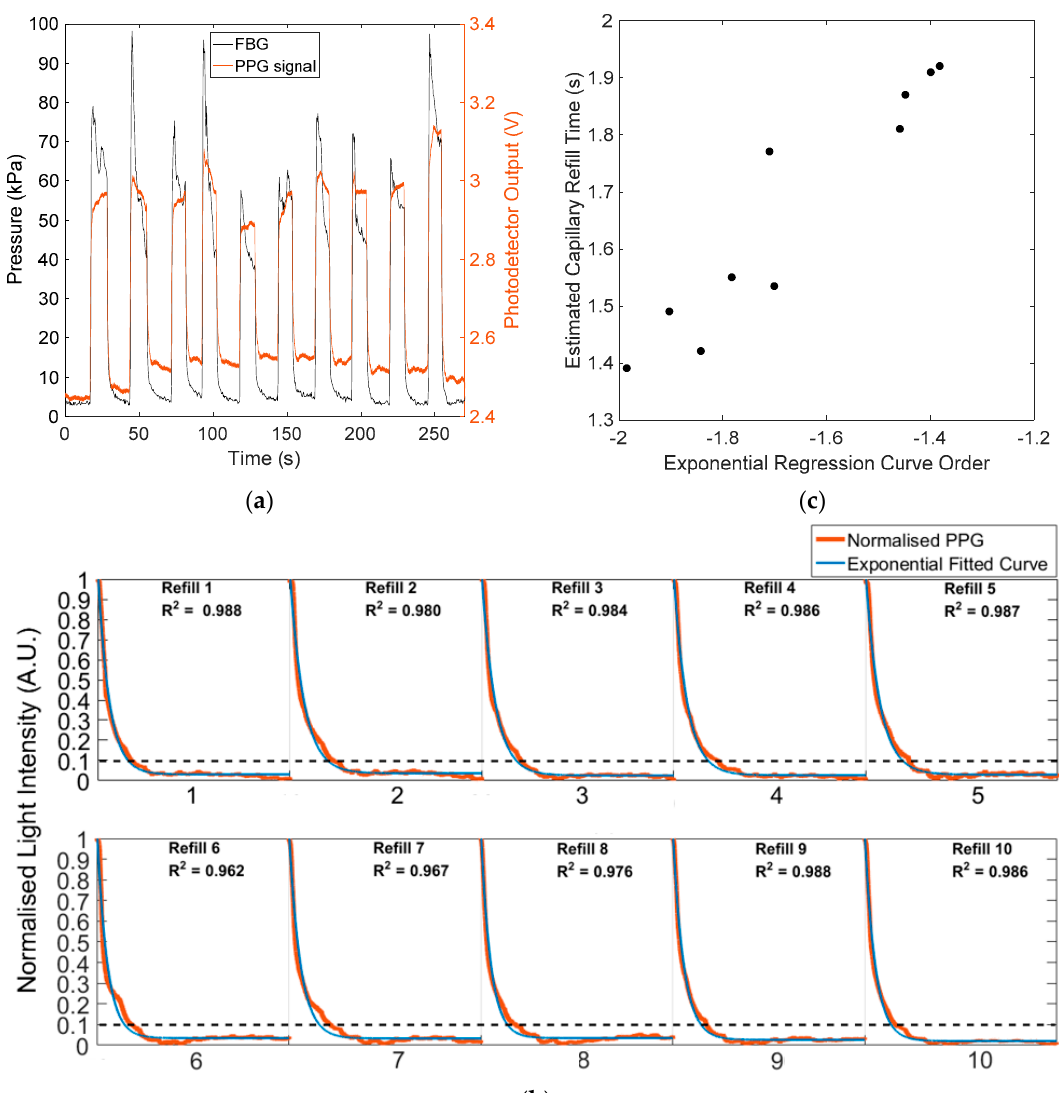
Figure 7. ( a ) Reflected PPG response to blanching pressure. The red line shows the light intensity of the reflected PPG signal, and the black line is the pressure recorded by the FBG. ( b ) Ten normalised capillary refills (red lines) and their exponential regression models (blue lines) over a 10 s period after contact pressure is released. The black dotted line is the 10% threshold applied for estimating CRT. R-squared values for all 10 exponential regression curves are > 0.96. ( c ) Estimated CRT (with a threshold level of 10%) versus the order of exponential regression